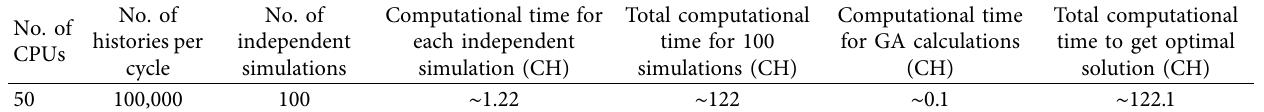
Table 8: Summary of computational time to get the best optimal